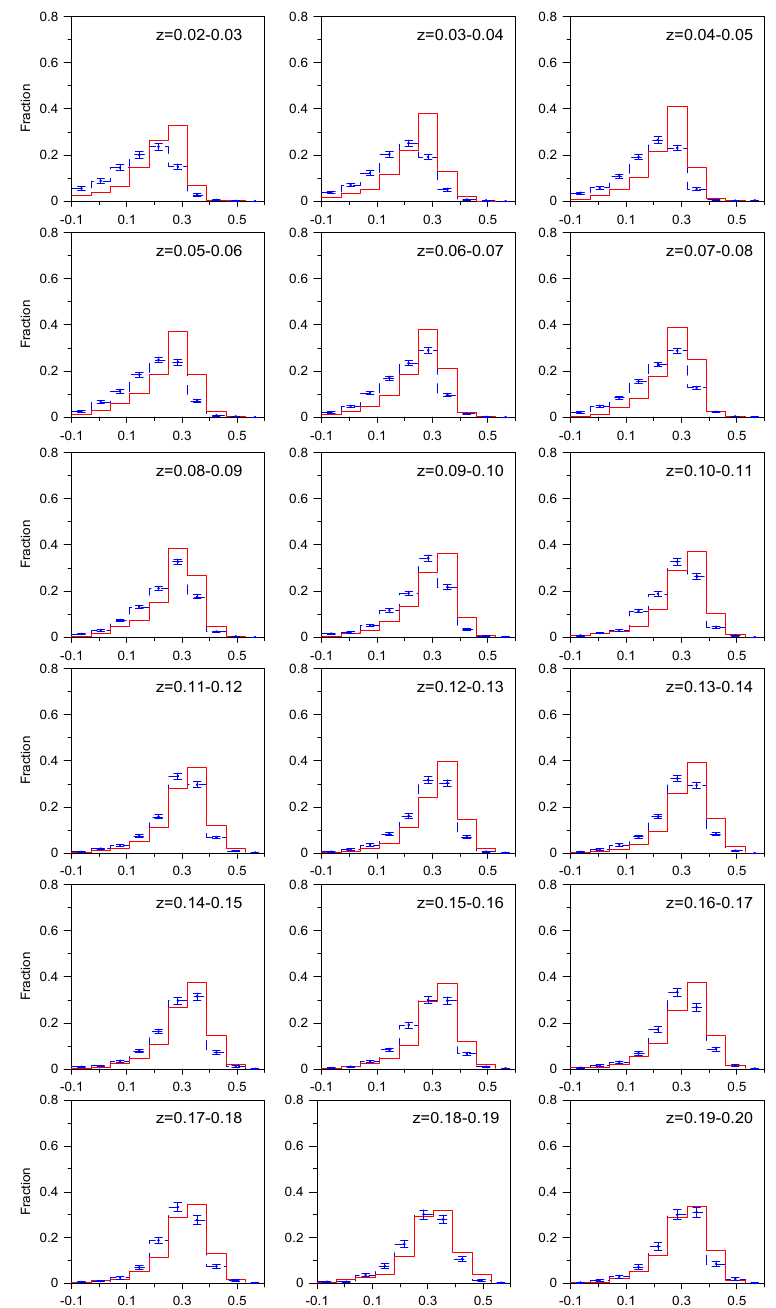
Fig. 5. Distribution of i – z colors. Designations are the same as in Figure